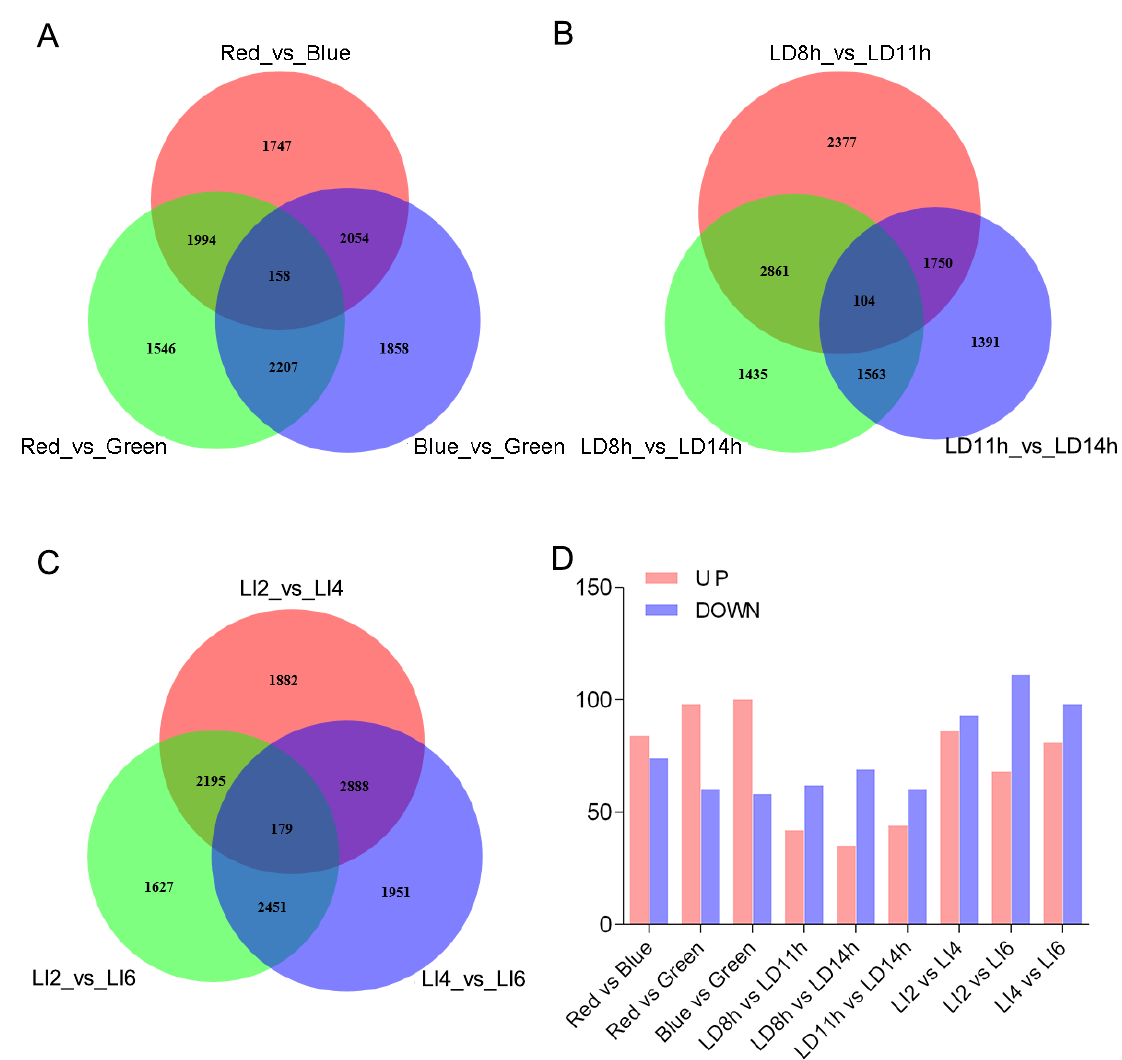
Figure 4. Di ff erentially expressed genes (DEGs) in response to three light conditions. ( a ) Venn diagram presenting the DEGs in a pair-wise comparison of light quality treatments. ( b ) Venn diagram presenting ————————– ————————– ————————– 54 the DEGs in a pair-wise comparison of photoperiod treatments. ( c ) Venn diagram presenting the DEGs in a pair-wise comparison of light intensity treatments. ( d ) Data regarding the up- and down-regulated genes in pair-wise comparisons of light